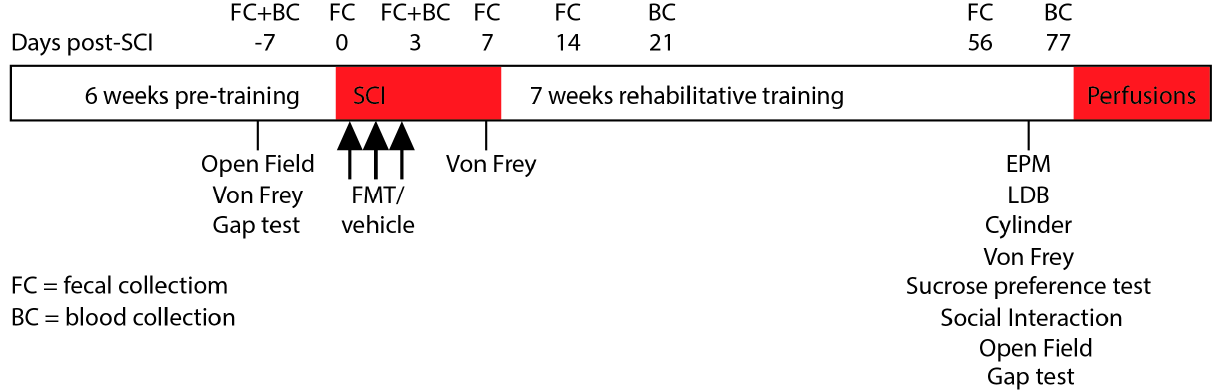
Figure 1. Experimental Timeline.